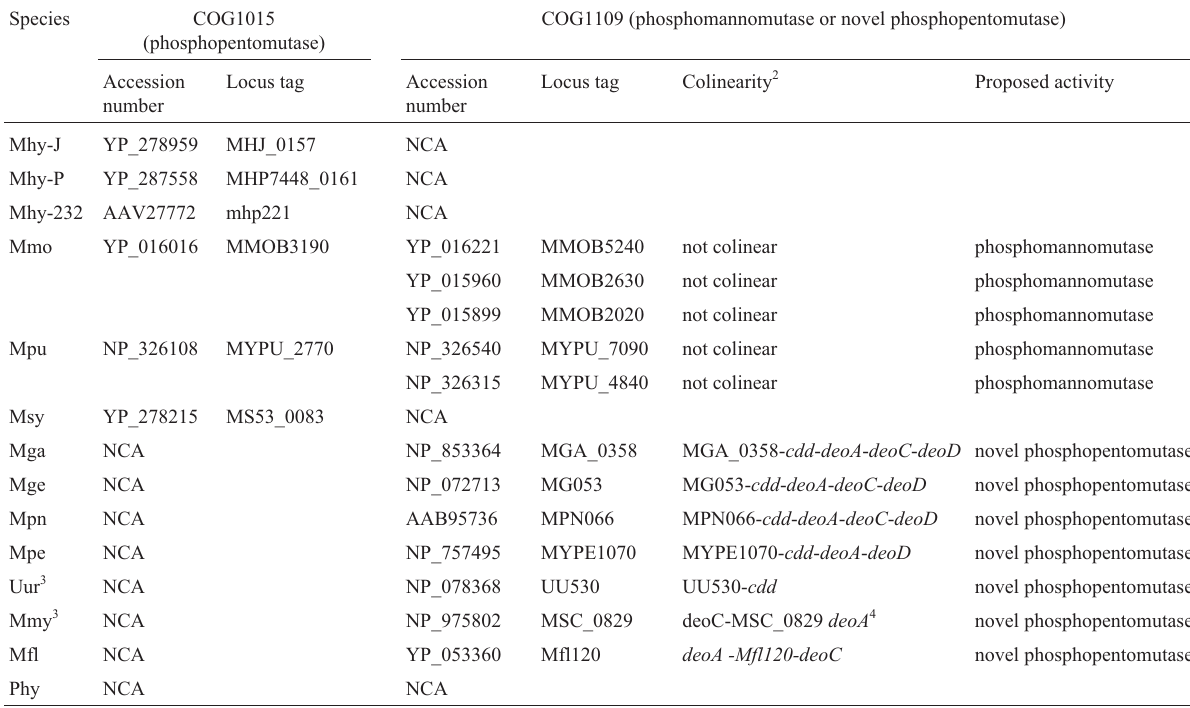
1 Abbreviations: Mhy, Mycoplasma hyopneumoniae (strains J, 7448 [P], and 232); Mmo, Mycoplasma mobile ; Mpu, Mycoplasma pulmonis ; Msy, Mycoplasma synoviae ; Mga, Mycoplasma gallisepticum ; Mge, Mycoplasma genitalium ; Mpn, Mycoplasma pneumoniae ; Mpe, Mycoplasma penetrans ; Uur, Ureaplasma urealyticum ; Mmy, Mycoplasma mycoides ; Mfl, Mesoplasma florum ; Phy, Onion Yellow Phytoplasma; NCA, no CDS annotated. 2 Identified CDSs containing COG1109 are represented here when the sequence is colinear to genes whose products are involved in (deoxy)ribose-1-phosphateand/or(deoxy)ribose-5-phosphatemetabolism. 3 Phosphopentomutaseactivitydetected(Cocks etal .,1985). 4 deoA geneislo- cated on the opposite